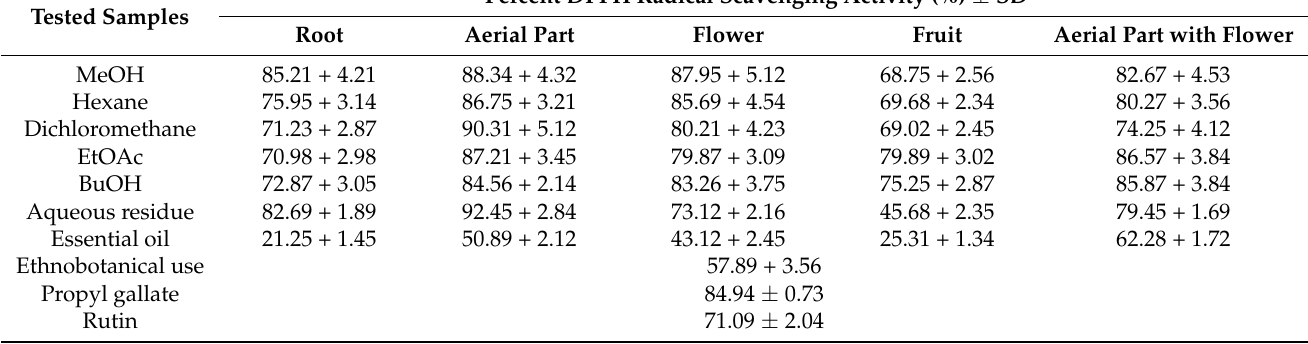
Table 5. DPPH radical scavenging activity of the extracts, sub-extracts, essential oils, and ethnobotan- ical use from Hypericum scabrum (%).